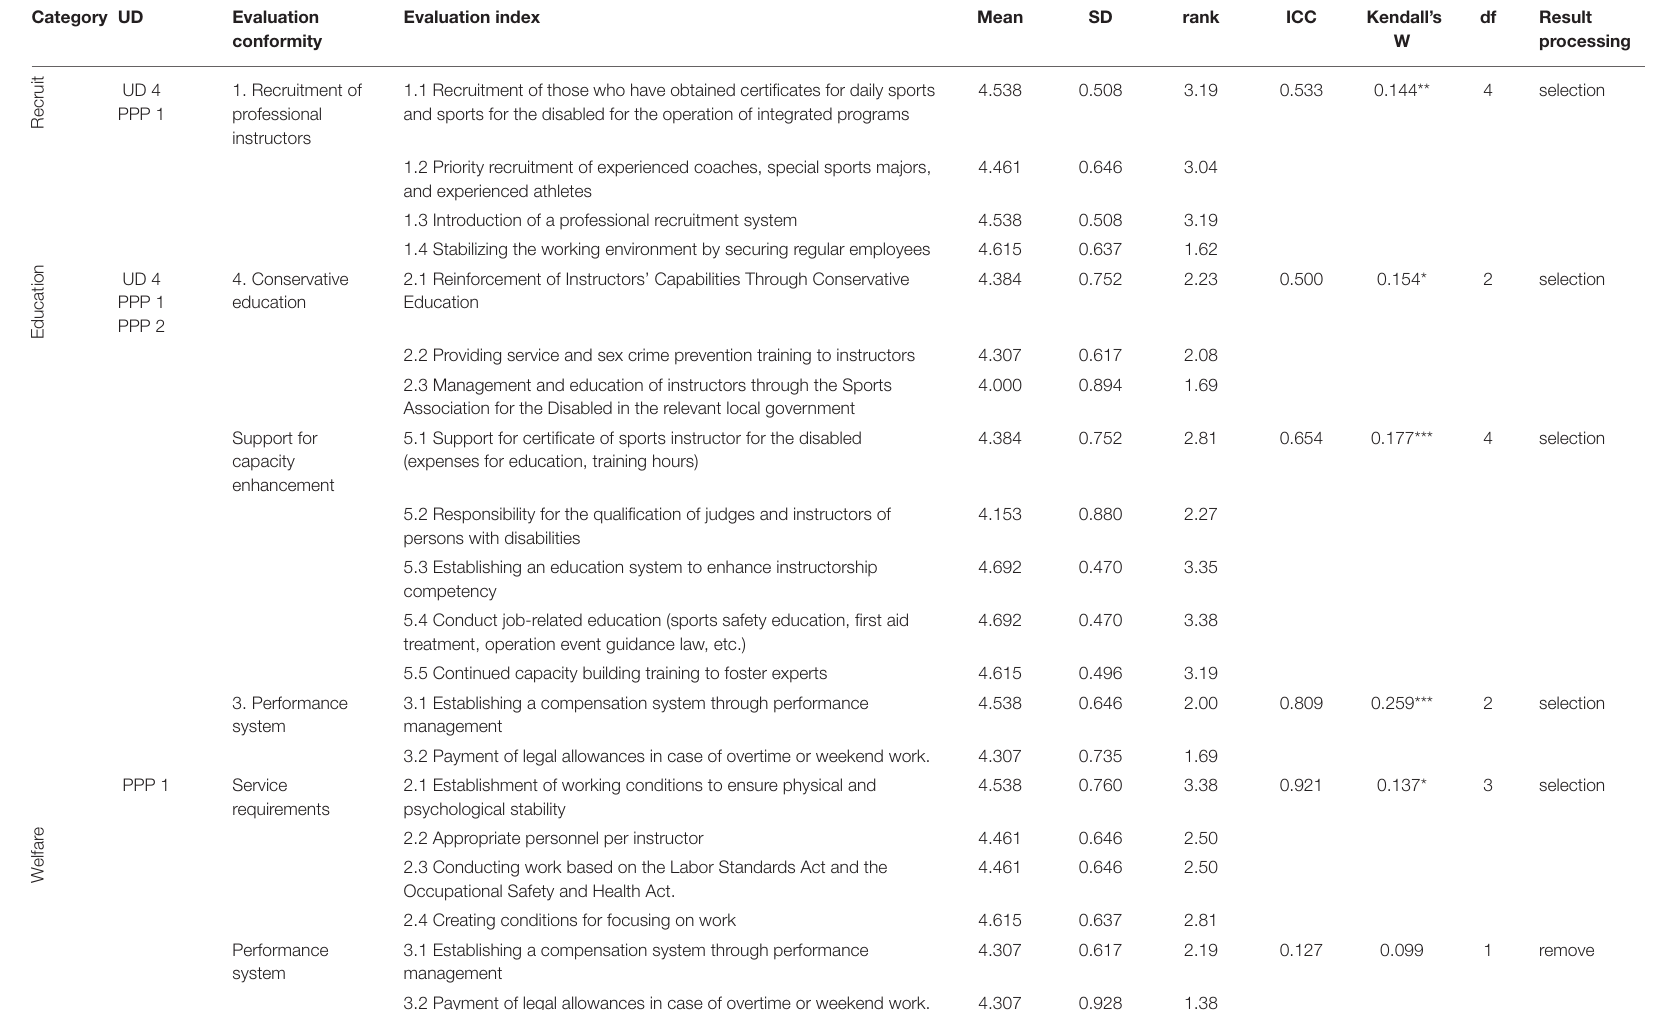
TABLE 5 | Contents of evaluation index and Results of analysis of reliability, and validity of evaluation indicators. Category UD